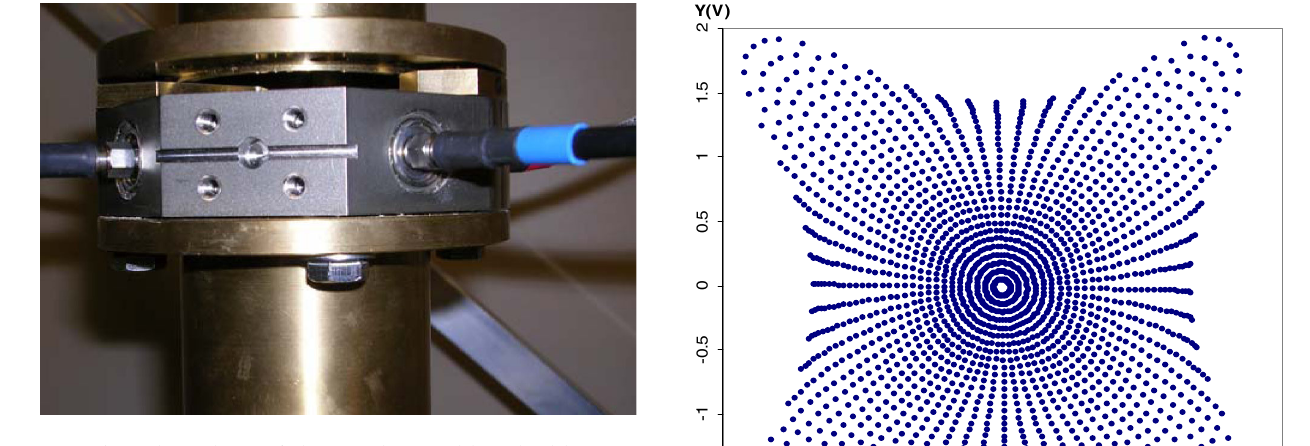
FIG. 15. (Color) Photo of the template positioned with pawns above the BPM block. The rod is positioned at the center of the BPM in X and Y by electric contacts with the template. Afterwards, the template is removed and the upper flange is delicately screwed on the BPM. Two half crown pieces are inserted under the rf joint to maintain an equal height.